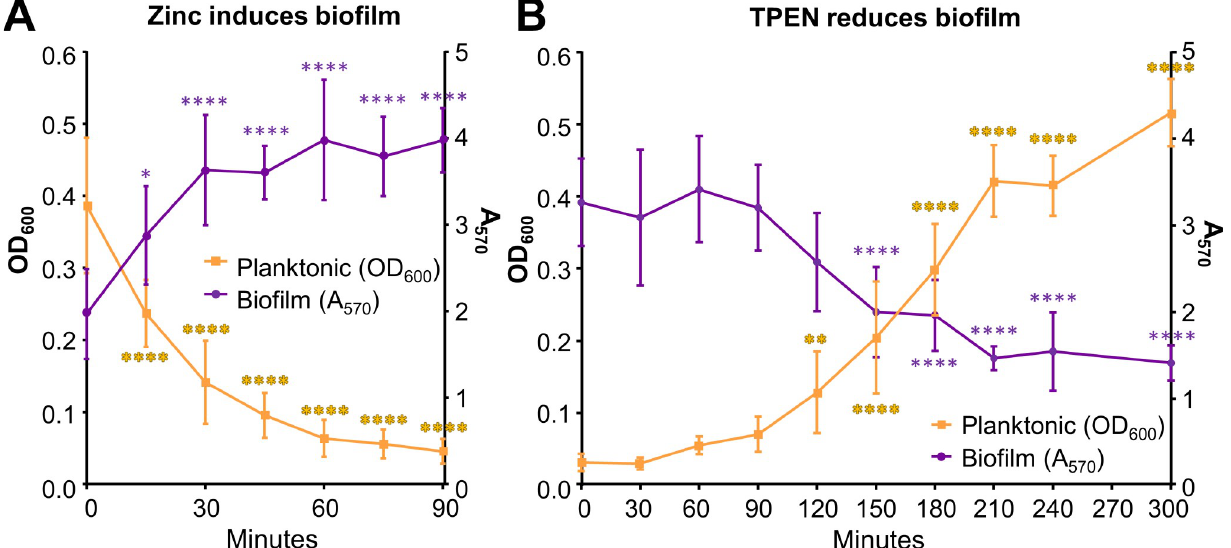
Fig 10. Zinc-dependent biofilm formation is reversible. (A and B) Time course of biofilm reversal. (A) mrpI -ON was cultured overnight in chelexed Minimal A + CAA. The next day, 5 μ M ZnSO 4 was added, and cultures were incubated for an additional 90 min. (B) mrpI -ON was cultured overnight in chelexed Minimal A + CAA + 5 μ M ZnSO 4 . The next day, 10 μ M TPEN was added, and cultures were incubated for an additional 3h. Planktonic growth (OD 600 ) and biofilm formation (A 570 ) were measured in replicate cultures at each time point. n = 5–7. Statistics: one-way ANOVA with Dunnett’s multiple comparisons test, compared with T = 0. � P < 0.05, �� P < 0.01, ��� P < 0.001, ���� P < 0.0001.